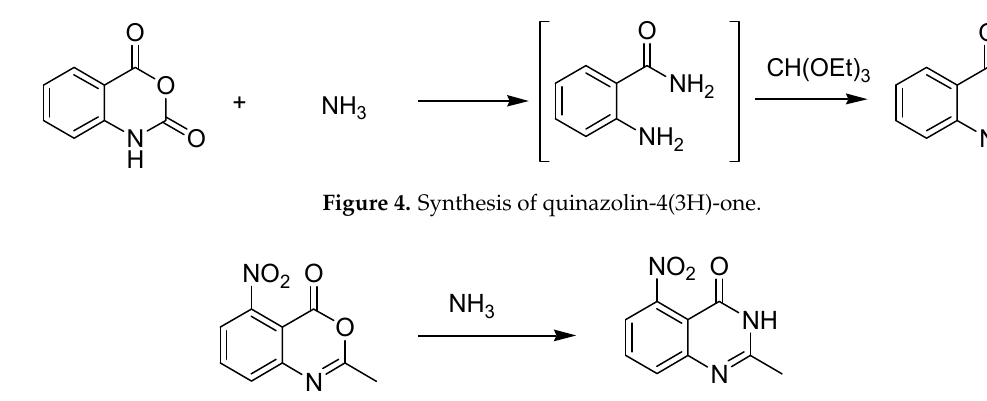
Figure 5. Synthesis of 2-methyl-5-nitroquinazolin-4(3H)-one.